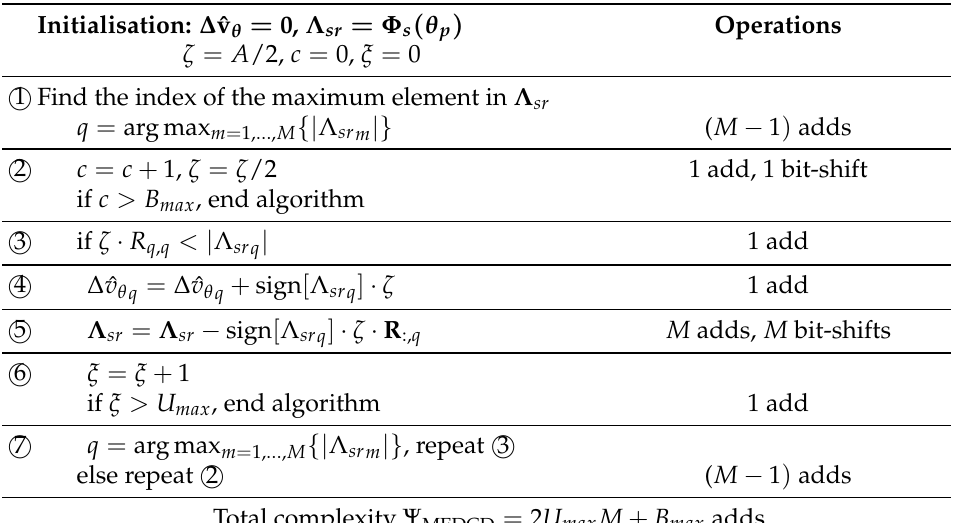
Table 1. Maximum element dichotomous coordinate descent